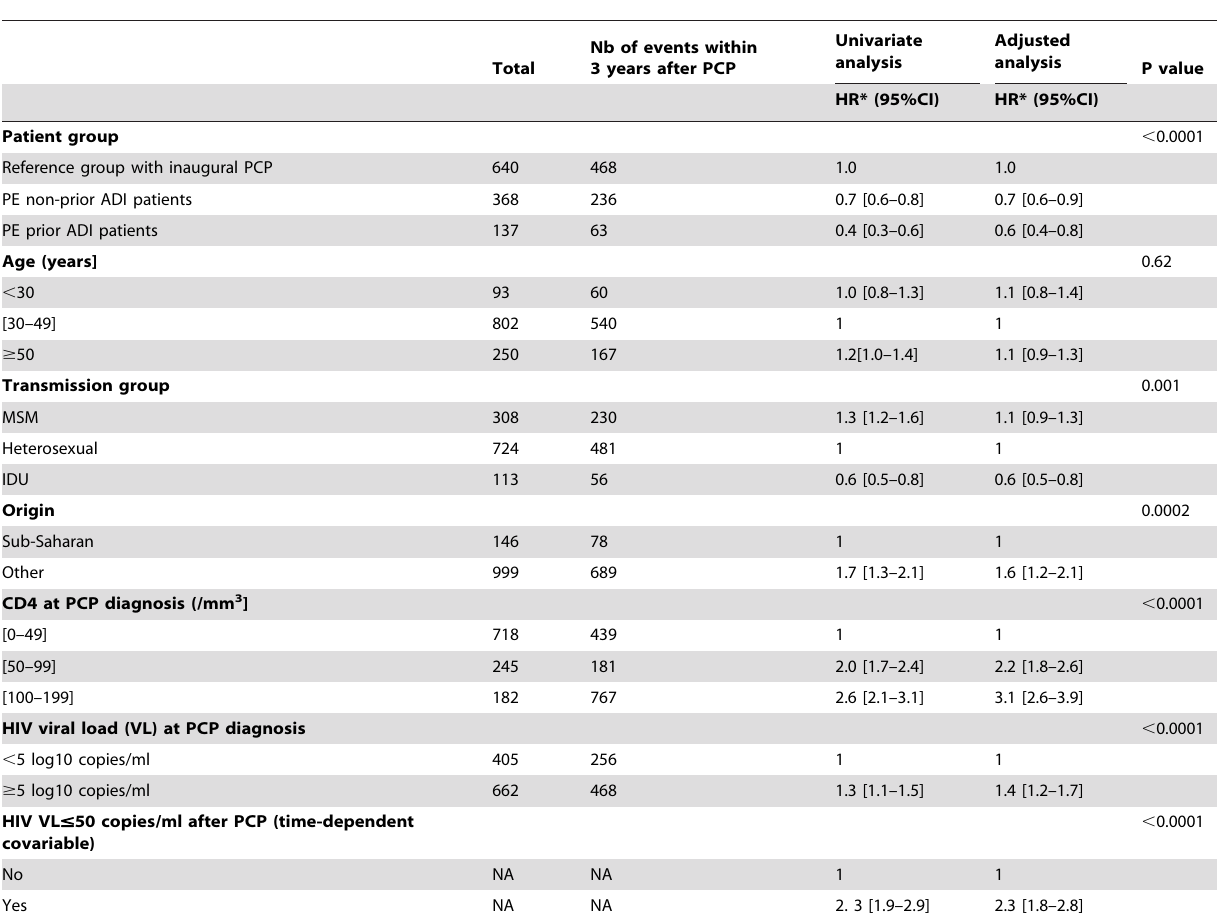
Table 2. Factors associated with immune reconstitution (CD4 . 200/mm 3 ) within 3 years after